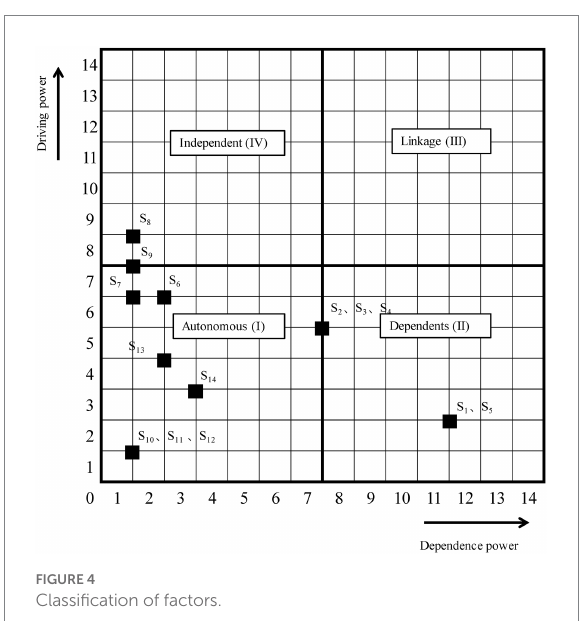
FIGURE 4 Classification of